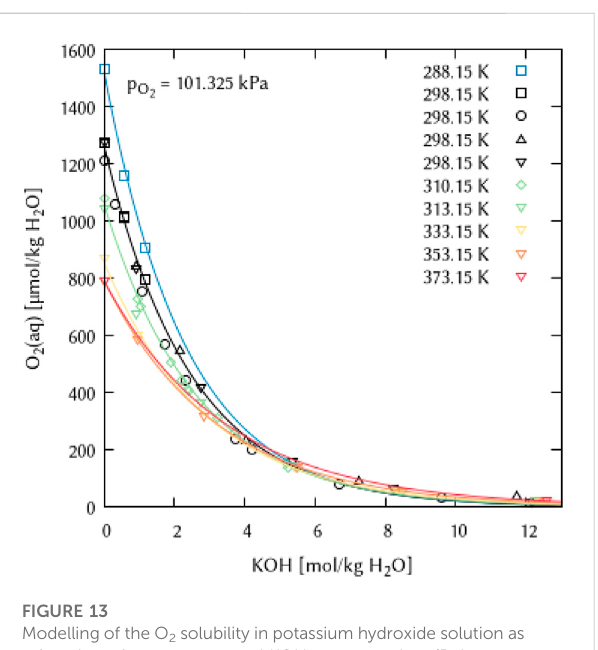
FIGURE 15 Modelling of the O 2 solubility in sodium sulfate solution as a function of temperature and Na 2 SO 4 concentration. (Points: Experimental data from ○ Millero et al. (2002a) and □ Millero et al. (2002b), Lines: this work).